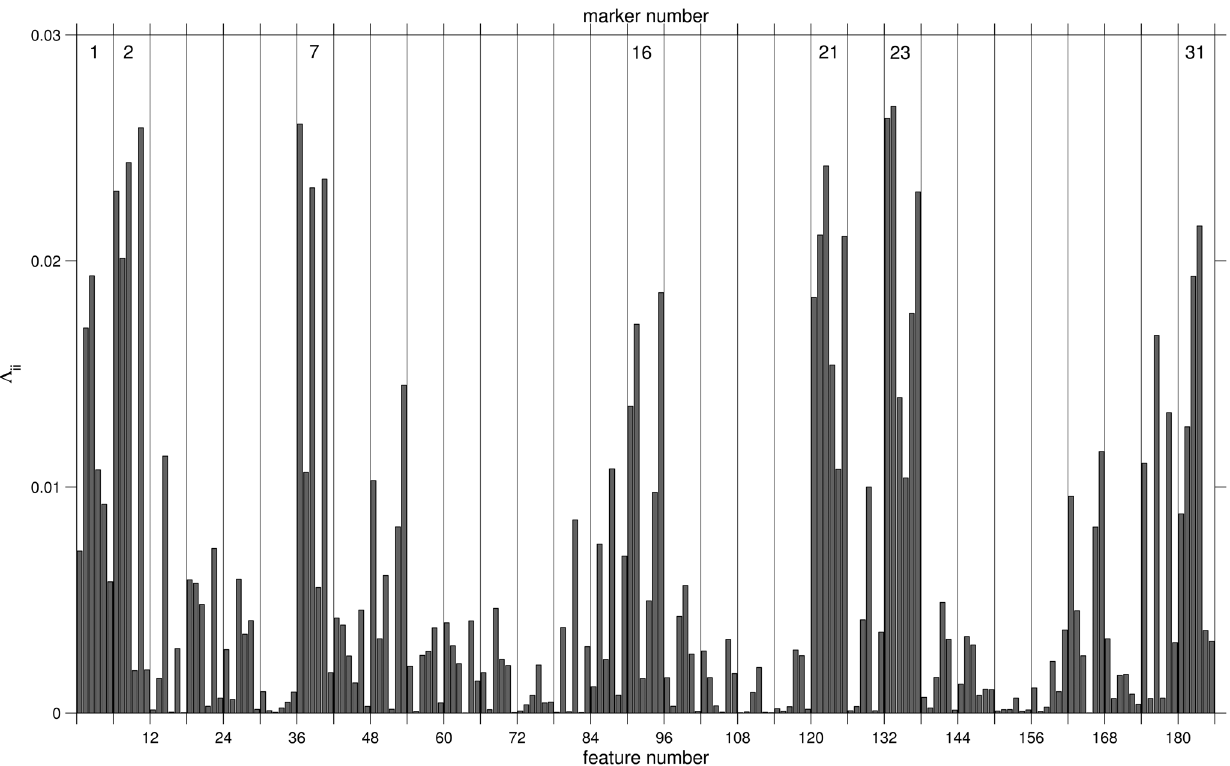
Figure 8. Relevance profile. Diagonal relevances L ii of features i ~ 1,2, ... ,186 : Vertical grid lines separate the groups of 6 quantities corresponding to each of the 31 markers, cf. Table 1. Marker numbers are given explicitly for 7 highly relevant ones.